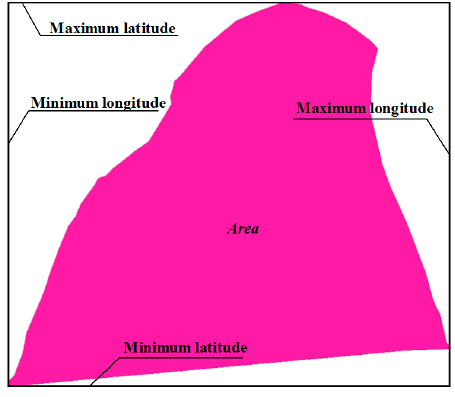
Figure 4. Schematic of the value range in chromosome.